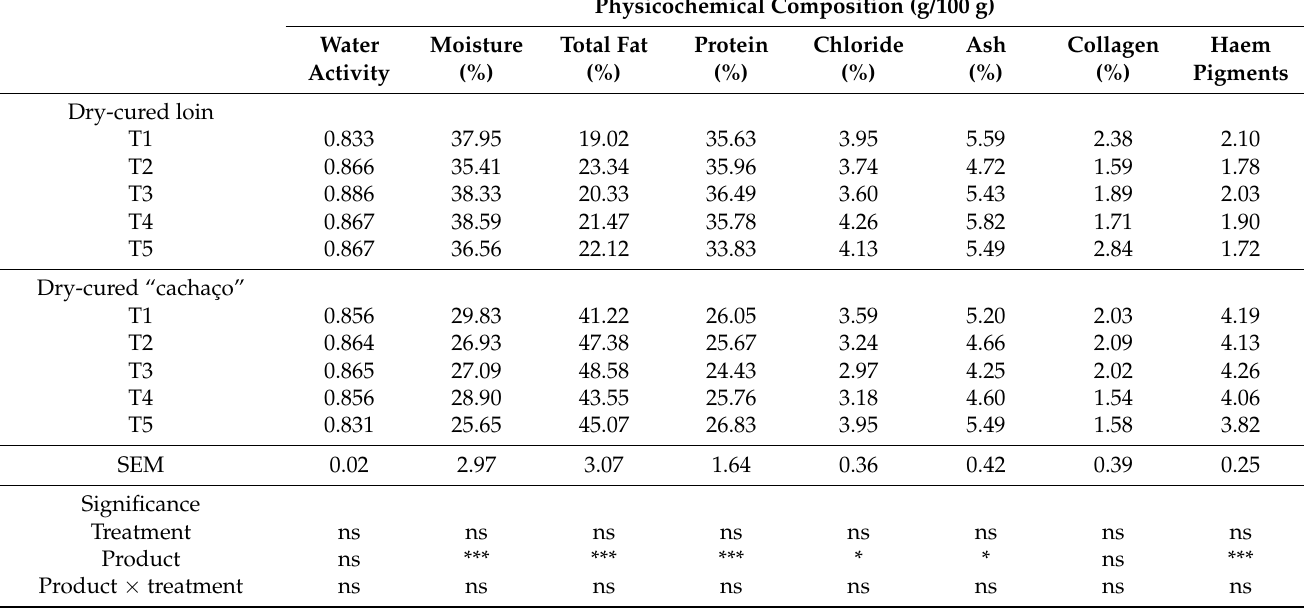
Table 1. Chemical composition of Longissimus thoracis et lumborum (LTL) muscle from the B í saro pig breed (loin and neck joints). Effect of treatment with olive cake, product, and interaction between product and